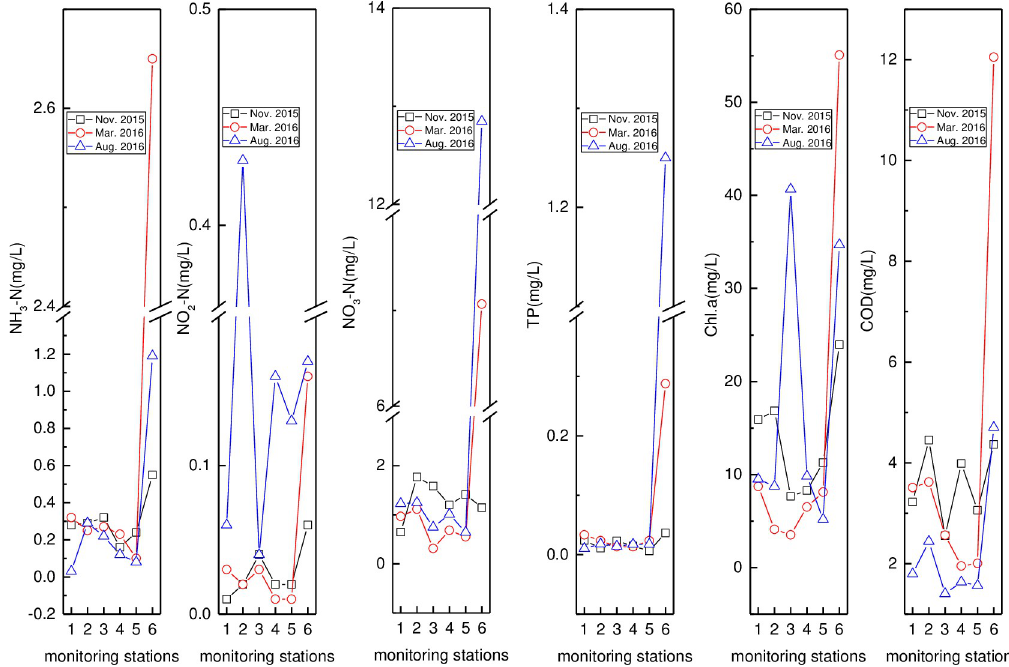
Fig 4. Variation of pH, water Temperature (T), Electrical Conductivity (EC), Dissolved Oxygen (DO) and Oxidation- Reduction Potential (ORP) in the reservoir, Bamen Bay, mangrove, and aquaculture. (Reservoir, Bamen Bay, mangrove, and aquaculture are represented by 1–4).